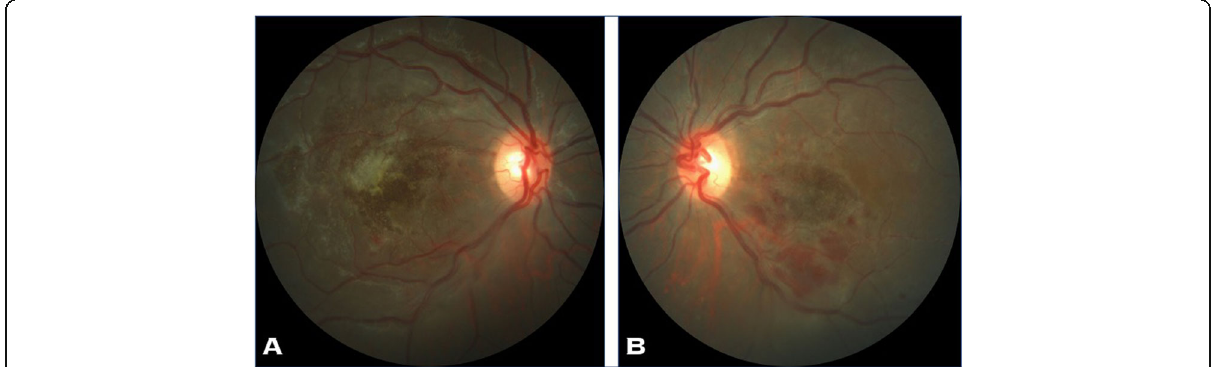
Fig. 2 a and b Fundus photo of the patient at first visit showing macular necrotising